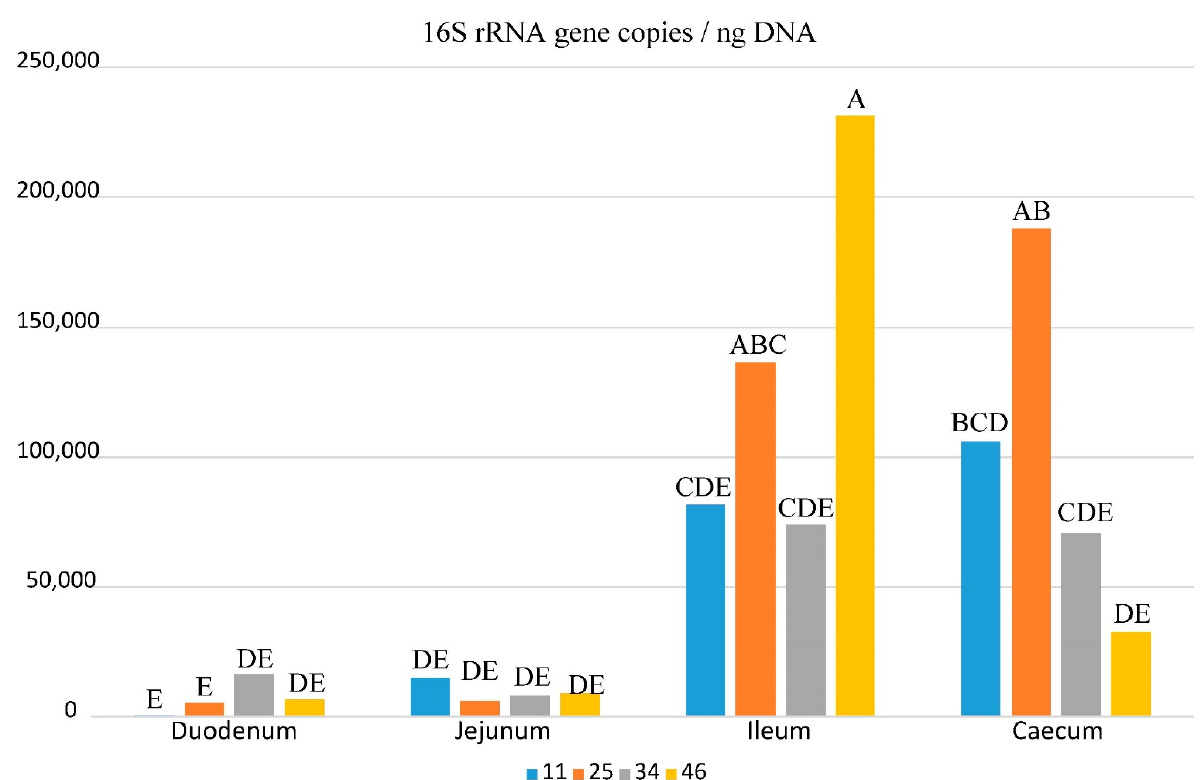
Figure 1. Estimated number of 16S rRNA gene copies/ng DNA for each intestine segment and age of chickens in days. The letters above each bar refer to the group each sample belongs to, varying from the higher (A) to the lower (E) number of gene copies. Such groups are statistically different ( p < 0.05) after Tukey’s adjustment for multiple comparisons (see also Supplementary Table S3).